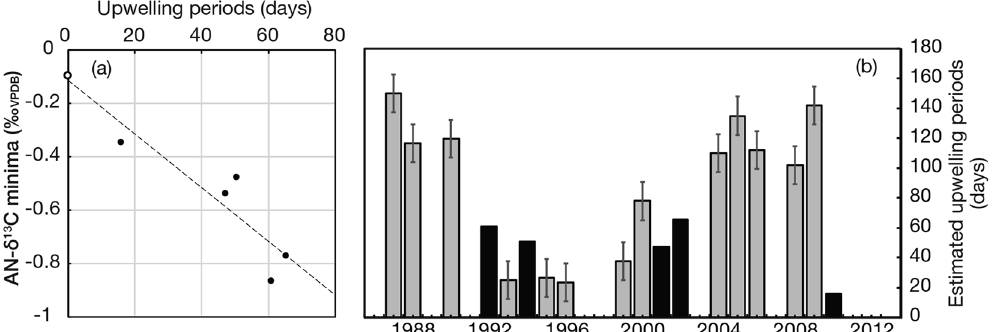
Figure 2. ( a ) Cross-plot of in situ low-SST periods and AN- δ 13 C minima. The dotted line indicates the regression between in situ low-SST periods and AN- δ 13 C minima (filled circles) and estimated δ 13 C anomaly value for no upwelling periods (r = − 0.937, P < 0.05, n = 6). The δ 13 C anomaly value for no upwelling (open circle) was estimated from in situ δ 13 C DIC-SW from the Arabian Sea 36 and the value of δ 13 C in isotopic equilibrium between coral carbonate and seawater 37 ( b ) Estimated upwelling periods from AN- δ 13 C minima. Black bars indicate the years which were used for the regression between in situ low-SST periods and δ 13 C anomaly